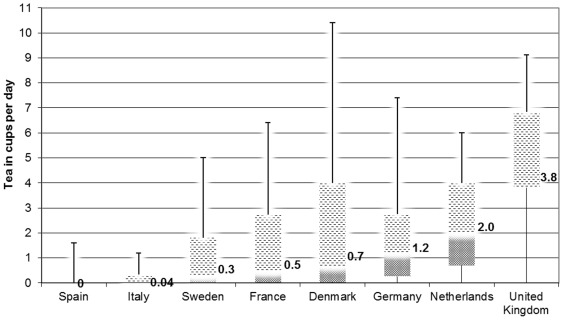
Tea consumption based on data from a food frequency questionnaire in the sub-cohort of the EPIC-InterAct project by country (n = 15,227).Bar represents median (p25–p75); error line represents p5 till p95.